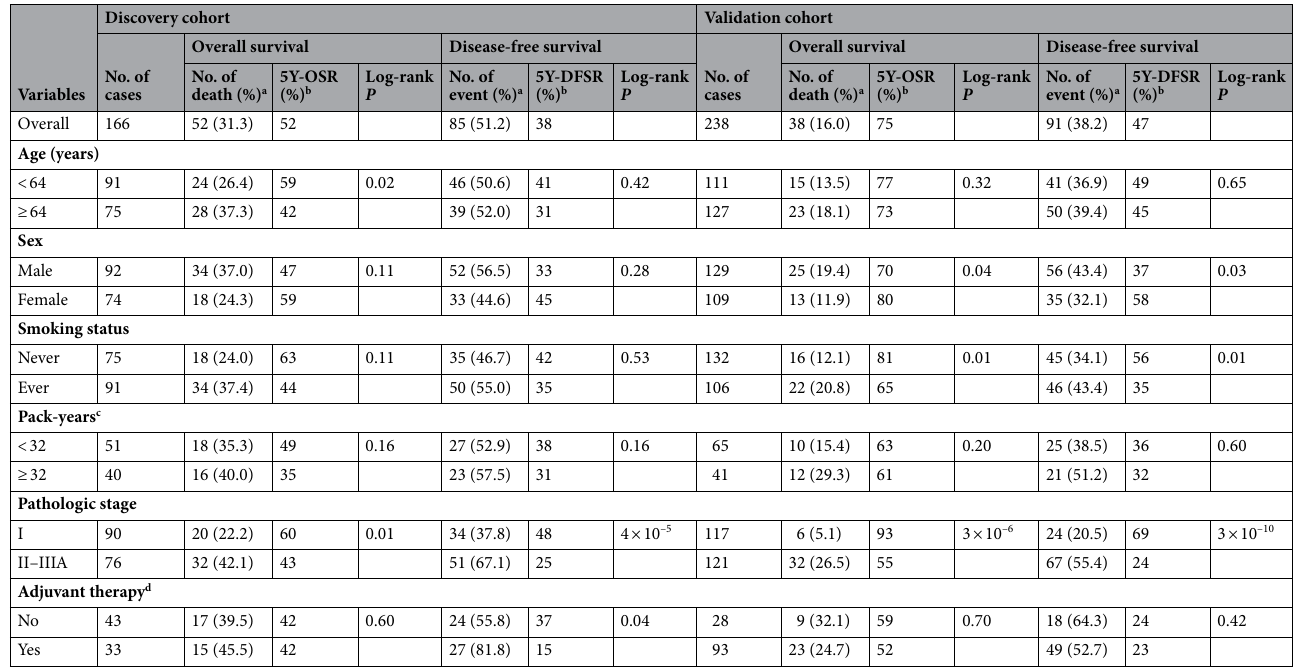
Table 1. Univariate analysis for overall survival and disease-free survival by clinicopathologic features in the discovery and validation cohorts. a Row percentage. b Five year-overall survival rate (5Y-OSR) and 5 year- disease free survival rate (5Y-DFSR), proportion of survival derived from Kaplan–Meier analysis. c In ever- smokers. d In pathologic stage II +